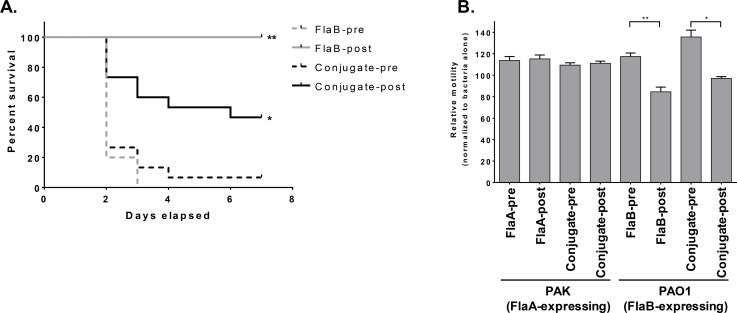
Functional activity of anti-PA Fla antibodies in-vitro and in-vivo.(A) Naïve mice (15 per group) were passively transferred with pooled paired pre-immune (dashed line) or vaccine-induced (solid line) antisera from rabbits immunized with the conjugate (black line) or rFlaB alone (grey line) and then infected by burn wound inoculation with PA strain M2. Results are the combination of two independent experiments. P value by log rank assay for immunized mice and immune sera relative to control is indicated. (B) Pooled pre-immune or immune sera from rabbits immunized with FlaA, FlaB or the 4-component conjugate were assessed for motility inhibition with PA strains PAK (FlaA) or PAO1 (FlaB). Results are from duplicate samples on three separate plates and are normalized to motility with PBS alone and are representative of two independent experiments. Mean +/- standard error are shown. P value by paired t-test is indicated. * P≤ 0.05, ** P ≤ 0.001.